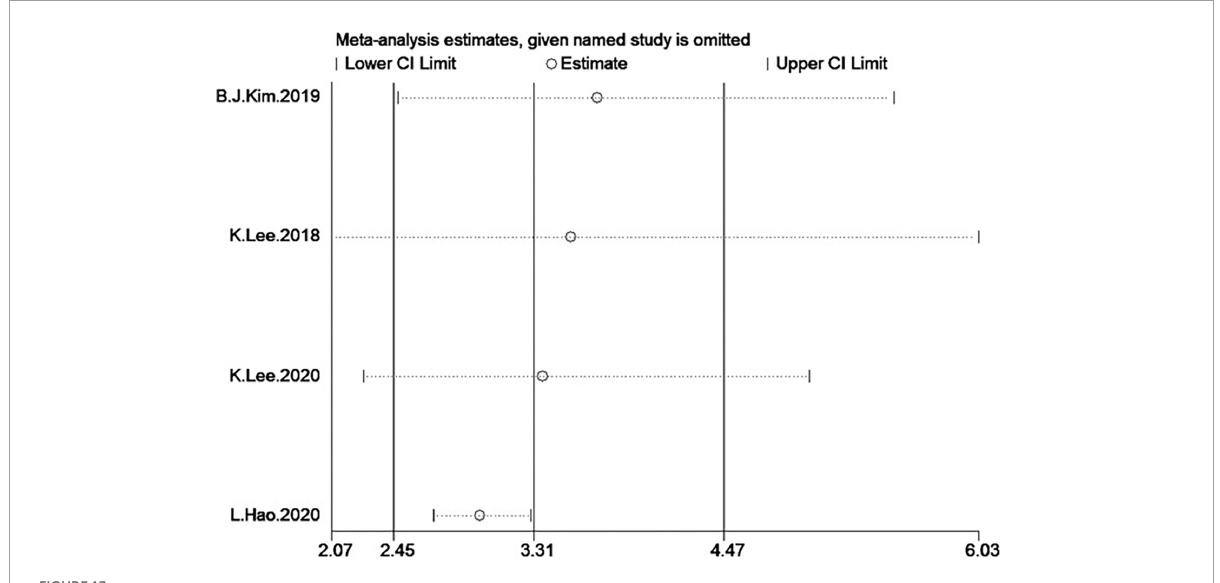
FIGURE13 Sensitivity analysis of NAFLD